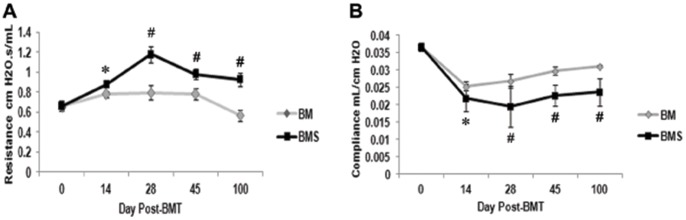
Kinetics of pulmonary function parameters post-BMT show that OB manifestations begin as early as 2 weeks.Lethally conditioned B10.BR mice were given B6 BM with (▪BMS) or without (◊BM) spleen cells. PFTs were done on the days indicated sequentially on the same mice. A. Resistance; B. Compliance. *p<0.05 vs day 0 for BMS (OB) group. #p<0.05 BMS vs BM group. N = 5–40/group/time point pooled from 4 experiments.